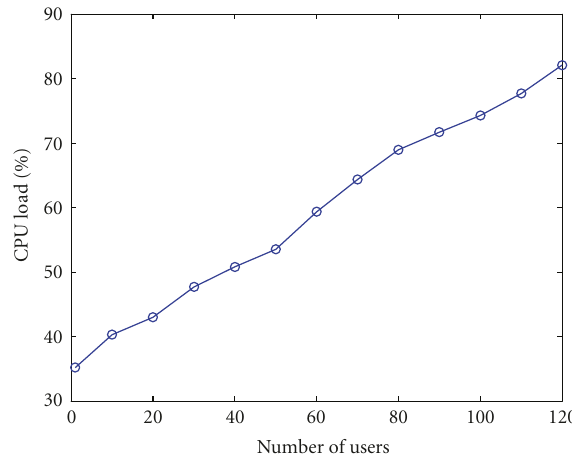
Figure 13: Computation cost versus number of users.